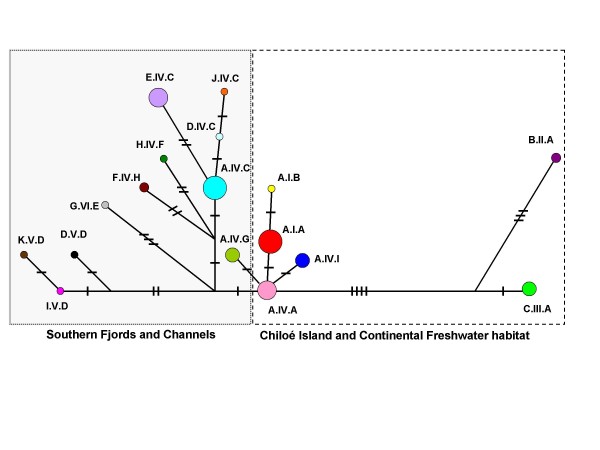
Median Joining Network of CR+ND5+Cyt-b haplotypes. Coloured circles represent haplotypes such as the figure 1 and 2. Haplotypes from the different environments Southern Fjords and Channels, Chiloé Island and Continental Freshwater habitat are indicated.